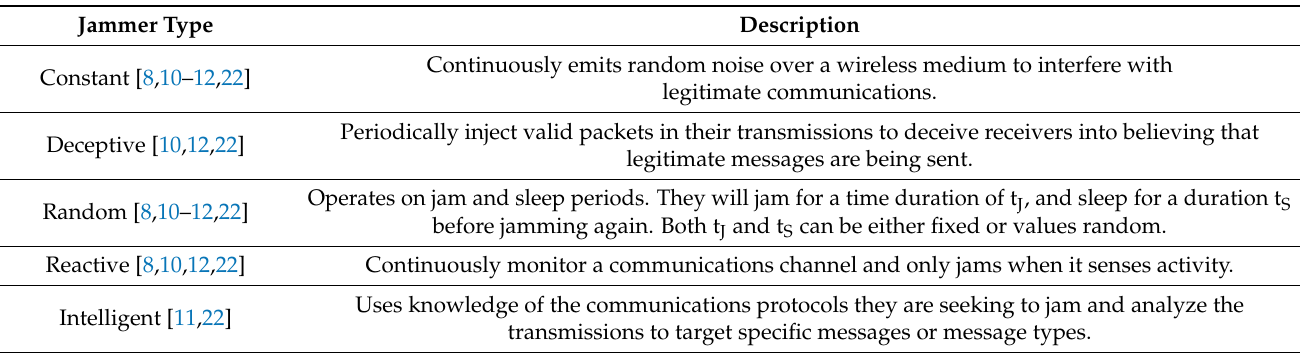
Table 2. Common Jamming